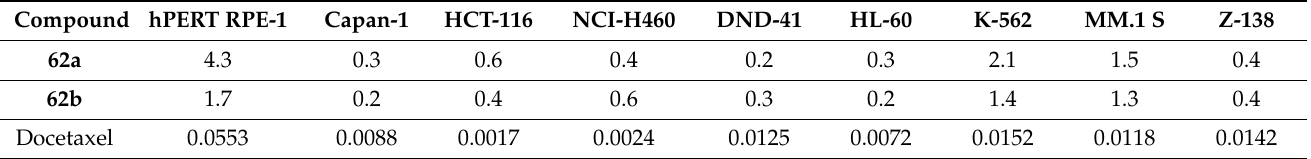
Table 4. Antiproliferative activity of compounds 28a and 28b measured in IC50 values (µM).